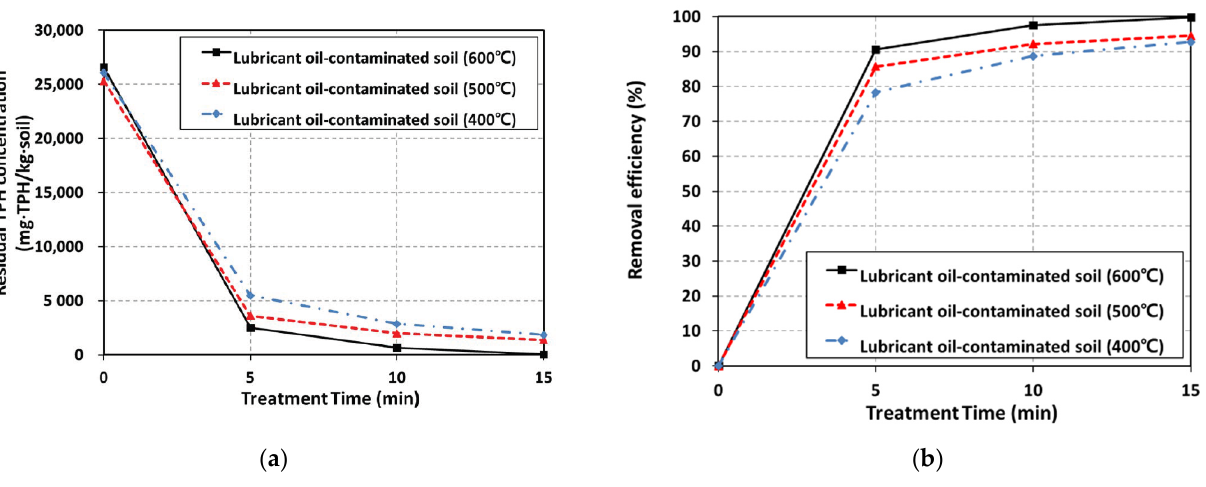
Figure 6. Remediation results: ( a ) Residual TPH concentration and ( b ) Removal efficiency.